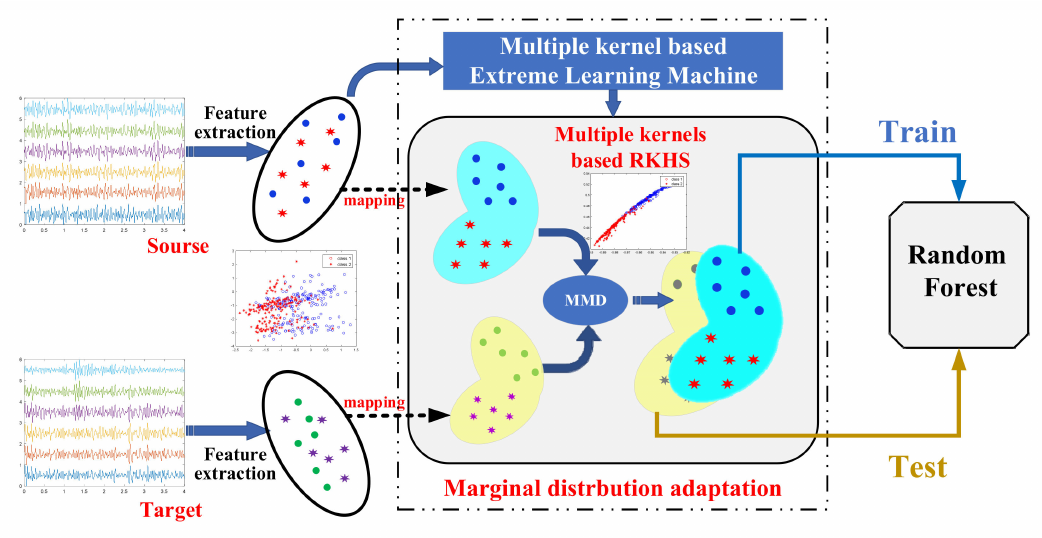
Figure 4. The joint distribution adaptation